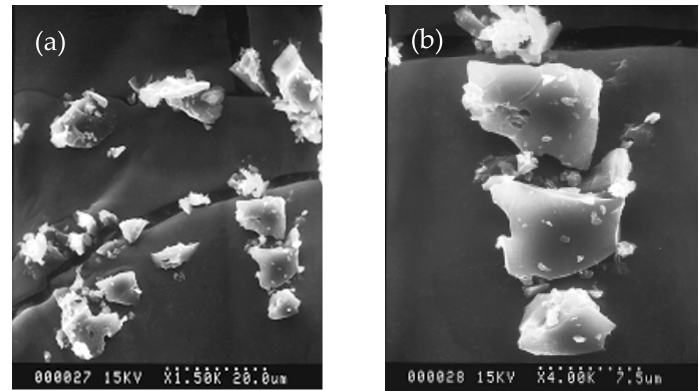
Figure 1. SEM micrographs of MC powder ( a ) ×1,500 and ( b ) ×4,000.